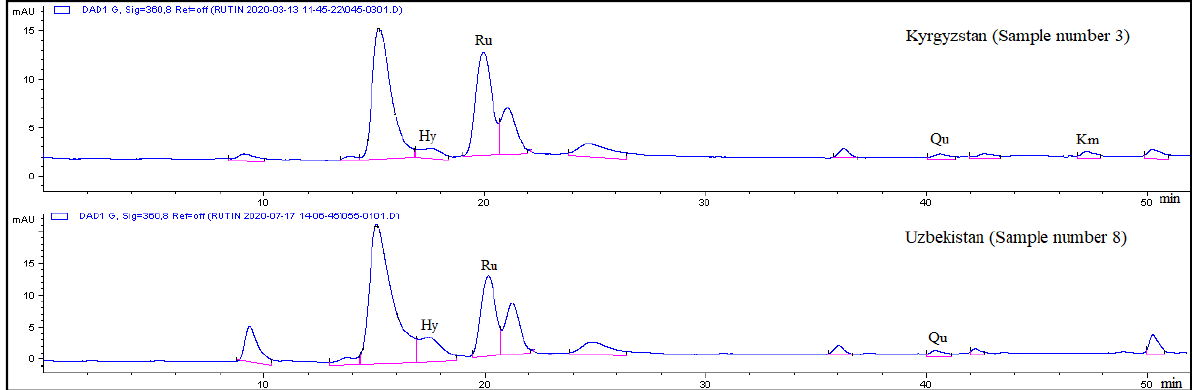
Figure 2. Chromatograms of 70%-aqueous-ethanol extracts from E. longistipitata leaves (detection at 360 nm). On the X-axis: retention time, min; on the Y-axis: the detector signal in units of optical density. Hy: hyperoside, Ru: rutin, Qu: quercetin, and Km: kaempferol.